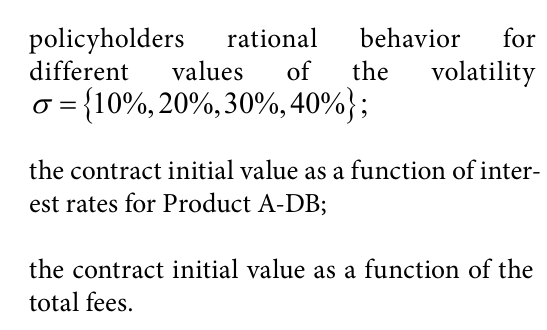
Table 5. Model parameters